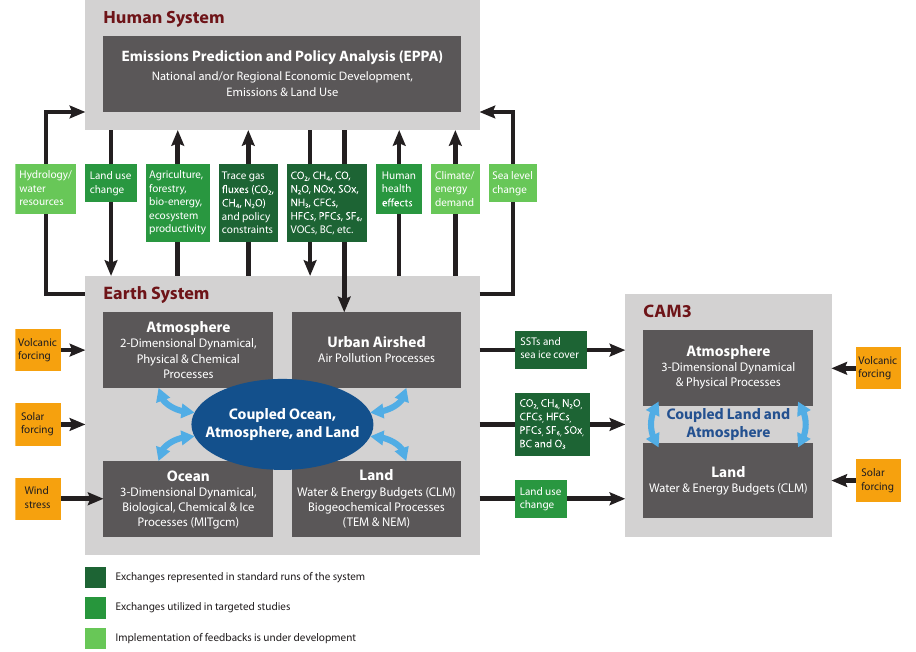
Fig. 1. Schematic of the IGSM-CAM framework highlighting the coupled linkages between the physical and socio-economic components of the IGSM2.3 and the linkage between the IGSM and